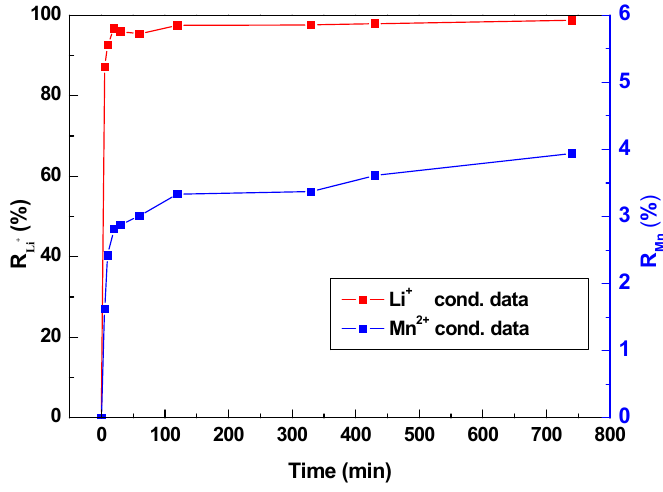
Figure 12. Desorption and Dissolution loss behavior of LMO-1.